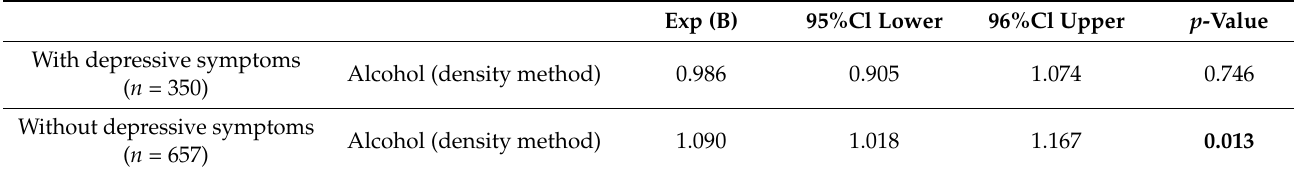
Table 5. Relationship between alcohol intake and CP stratified by sex and depressive